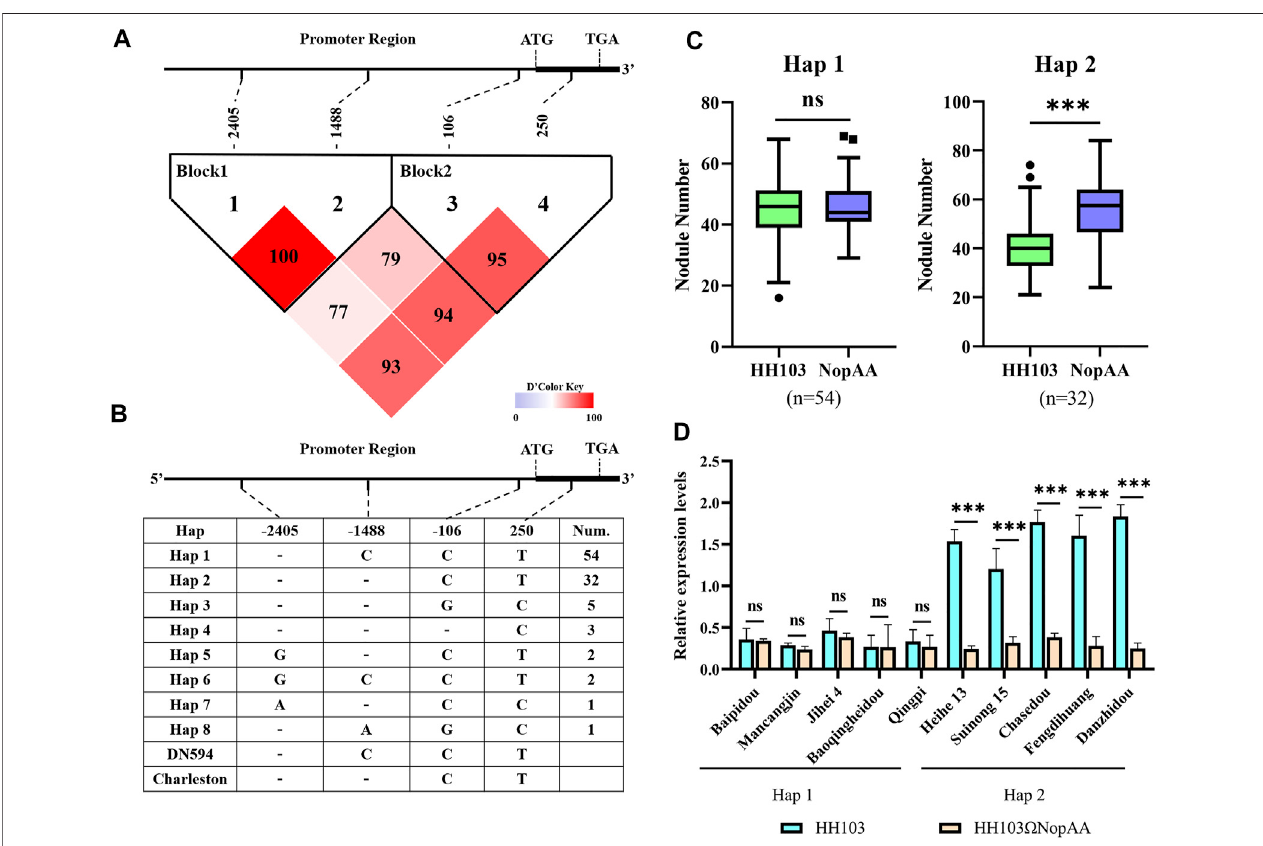
FIGURE 5 | Haplotype analysis of GmARP . (A , B) Haplotype analysis of GmARP from 100 soybean resources. (C) NN of Hap1 and Hap2 inoculated with HH103 and HH103 Ω NopAA, data are presented asthe average ofthree different biological replicates and 15 plants for each replicate. (D) Gene expression of GmARP of Hap1 and Hap2 inoculated with HH103 and HH103 Ω NopAA (12 hpi). Signi fi cance was measured by t -tests. NN, nodule